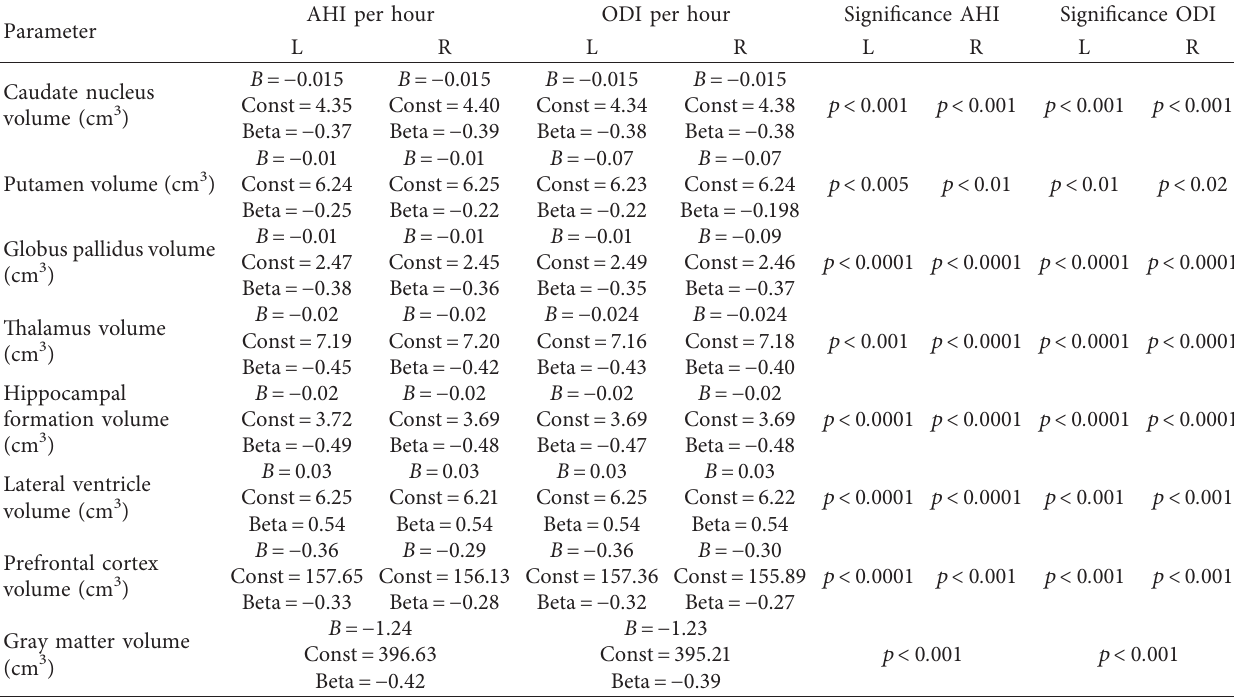
Table 4: Correlation matrix between polysomnographic parameters and volumes obtained.